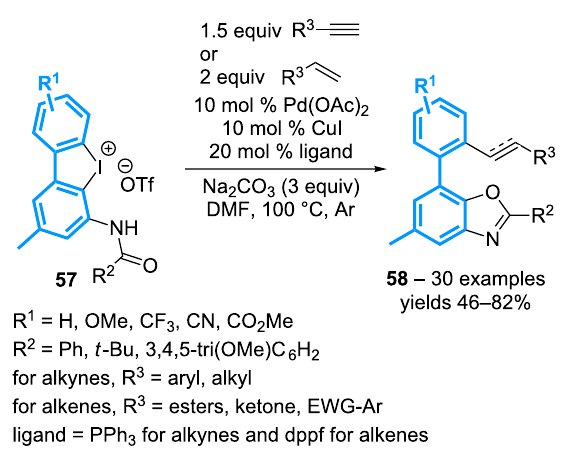
Scheme 21: Synthesis of triazolophenantridines from cyclic diaryl- λ 3 -